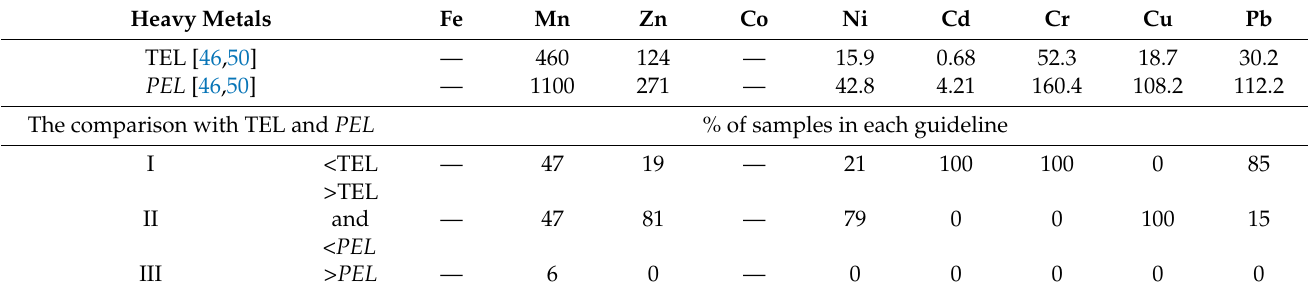
Table 4. Percentage of heavy metals in each category associated with biological risks.